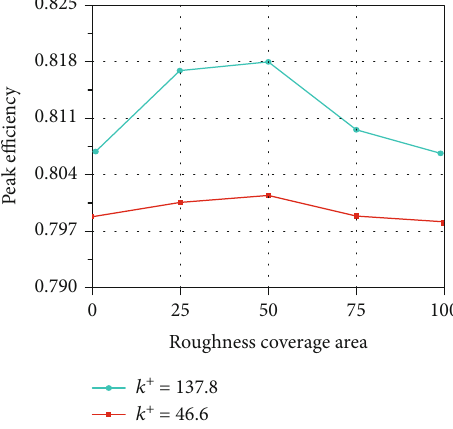
Figure 20: The variation in the peak e ffi ciency with di ff erent roughness coverage area at k + = 46 : 6 and k + = 137 : 8